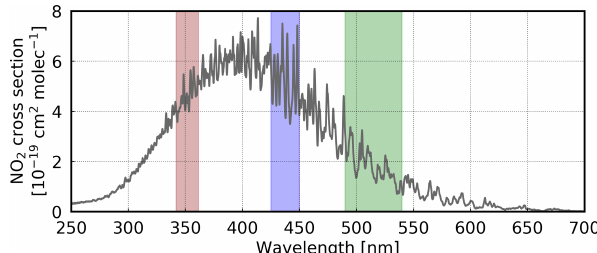
Figure 2. NO 2 absorption cross section measured at 243K with the GOME-2 instrument now deployed on MetOp-A. The fitting windows used in this study are shaded by colour. Red: new NO 2 fitting window in the UV spectral range. Green: NO 2 fitting window in the green spectral range. Blue: NO 2 fitting window in the blue spectral range (see Table